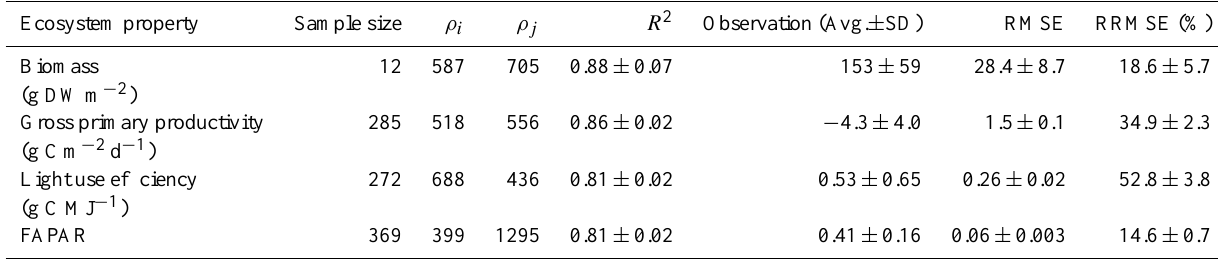
Table 2. Wavelengths of the hemispherical conical reflectance factors (HCRF) ( ρ i,j ;nm) used in the normalised difference spectral indices (NDSI) that generated the strongest correlations with ecosystem properties. DW is dry weight, FAPAR is the fraction of photosynthetically active radiation absorbed by the vegetation, Avg. is average, SD is standard deviation, RMSE is root-mean-square error, and RRMSE is relative RMSE. Ecosystem property ρ